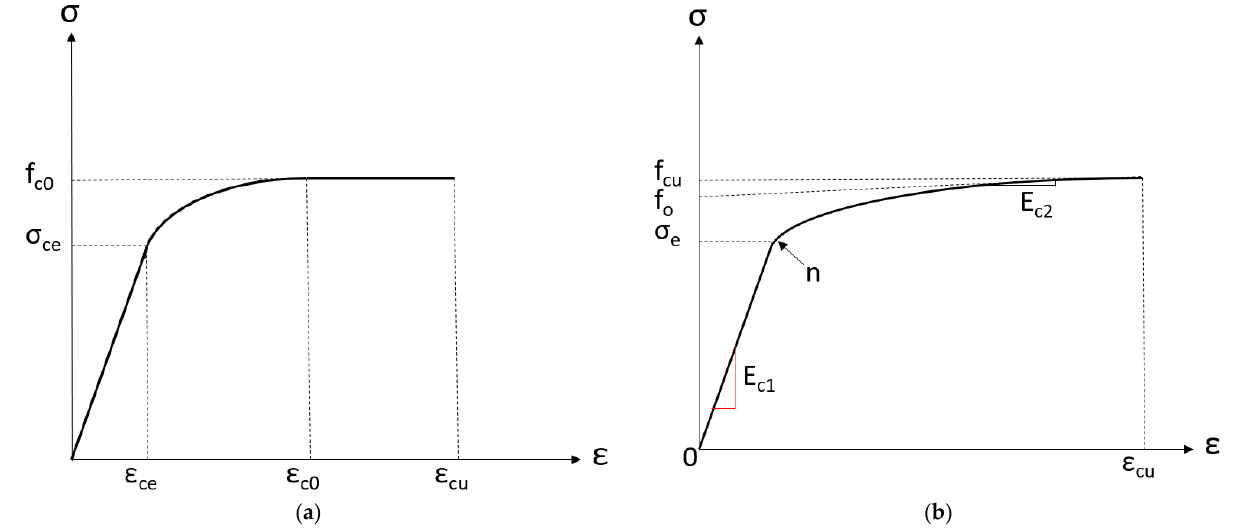
Figure 4. ( a ) Quadratic Model QM2 by Li et al., (2019, 2020) [19,48]; ( b ) Richard-Abbott (RA) by Wei et al., 2020 [46].